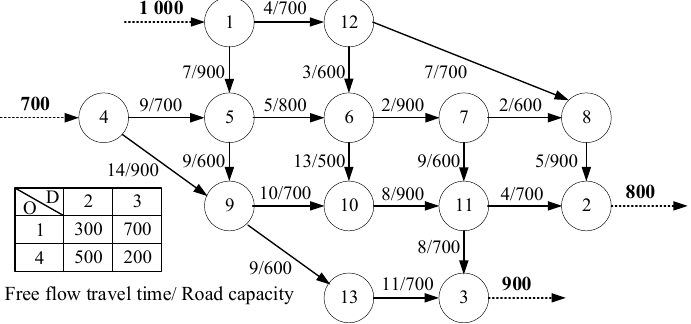
Figure 2. Topology, link characteristics, and OD demands of the Nguyen–Dupuis